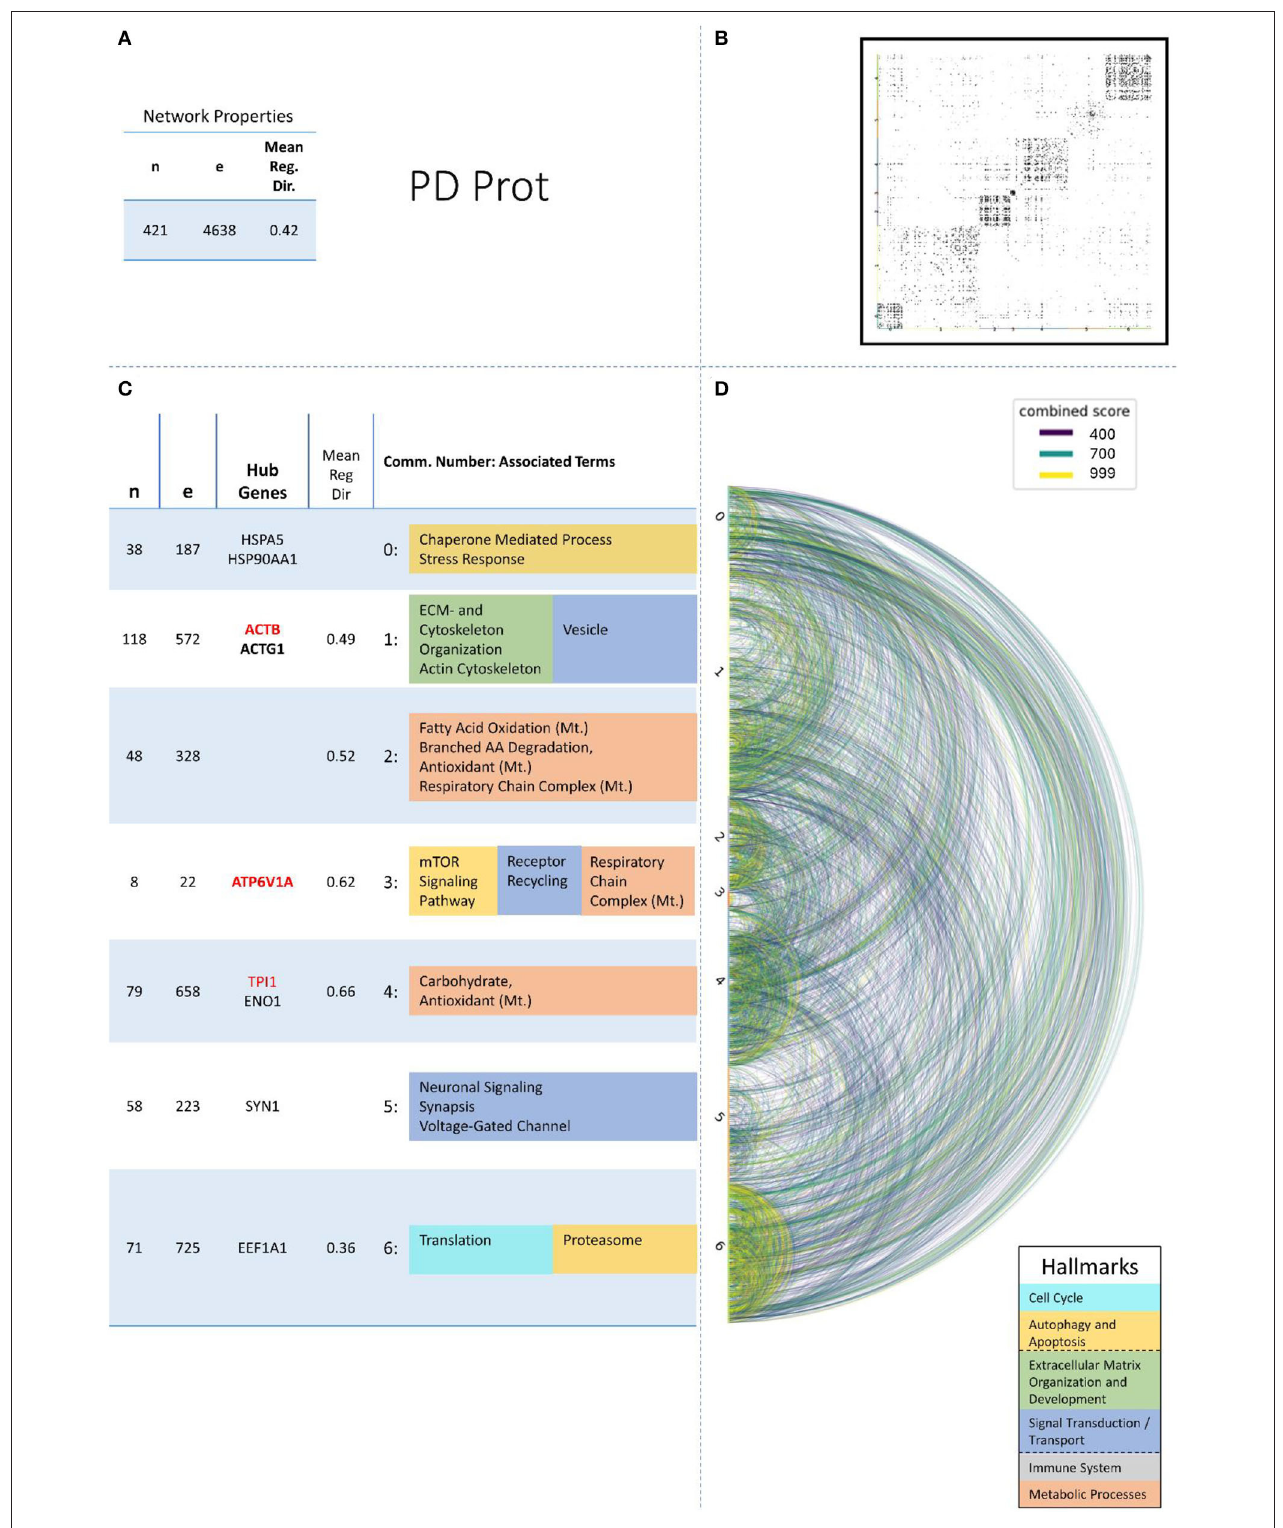
FIGURE 5 | Summarizing figure of the network analysis results of the proteomic layer of PD. The general properties. such as number of nodes (genes) and edges (a combined score > 400 between two nodes) of the PPI network constructed with all PD proteomic genes, are given in Subfigure (A) . The individual connections with